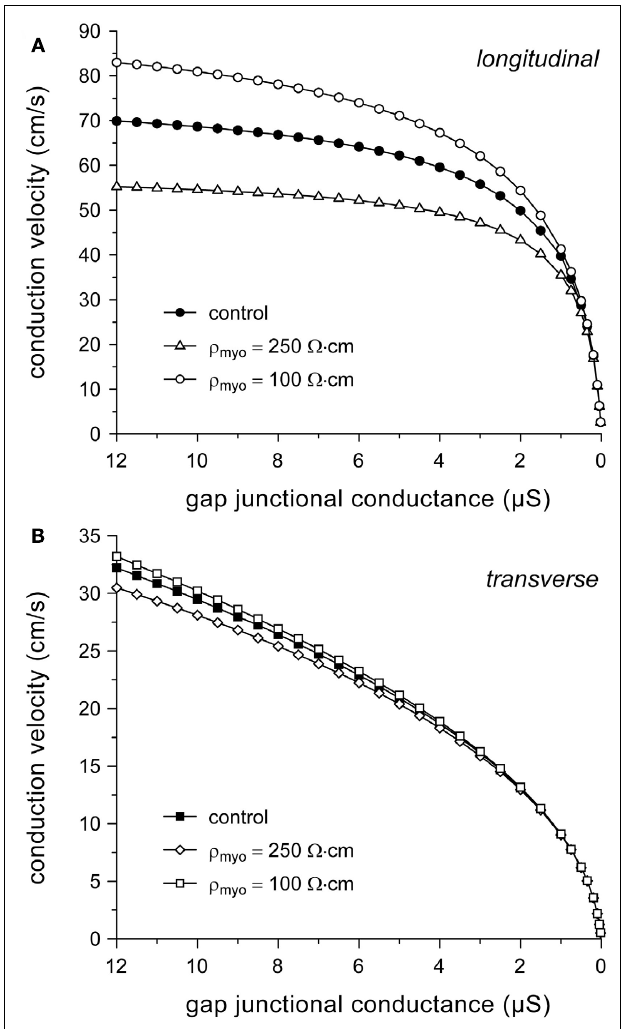
FIGURE 6 | Effect of halving or doubling sodium current ( I Na ) conductance on (A) longitudinal and (B) transverse conduction